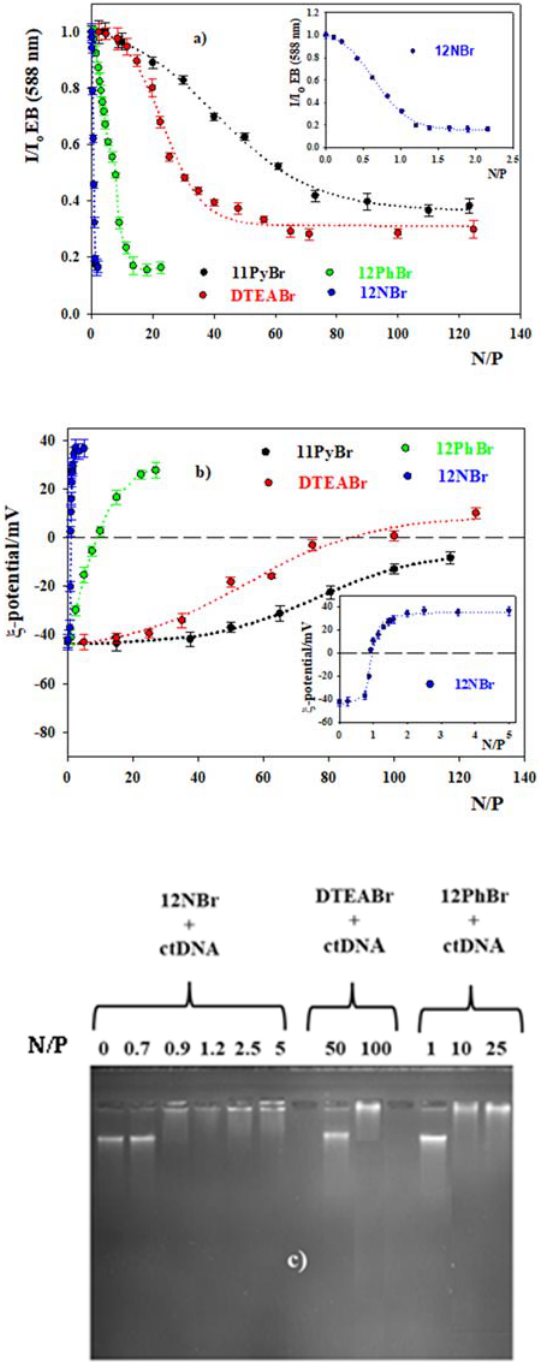
Figure 1. ( a ) Plots of I/Io as function of the charge ratio N/P. Experimental conditions: 10 mM HEPES (pH = 7.4), [EB]=2.4 × 10 − 6 M, [ctDNA] = 3.0 × 10 − 5 M, and T = 303.0 ± 0.1 K. ( b ) Plots of the variation of the zeta potential, ζ , with the charge ratio N/P, the experimental values are expressed as the mean ± SD ( n = 9). Experimental conditions: [ctDNA] = 3.0 × 10 − 5 M, HEPES 10 mM (pH = 7.4) and T = 303.0 ± 0.1 K. ( c ) Electrophoretic mobility shift assay on an agarose gel (1%) for surfactant/ctDNA complexes. Experiments were run in TAE buffer (40 mM tris-acetate, 1 mM EDTA) and stained with Red Safe. Electrophoresis was performed at 90 V until completion. The insets in Figure 1a,b correspond to the 12NBr surfactant. Figure 1 indicates that there are strong interactions between ctDNA and 12PhBr and 12NBr. This interaction was weak with DTEABr and, particularly, with 11PyBr.